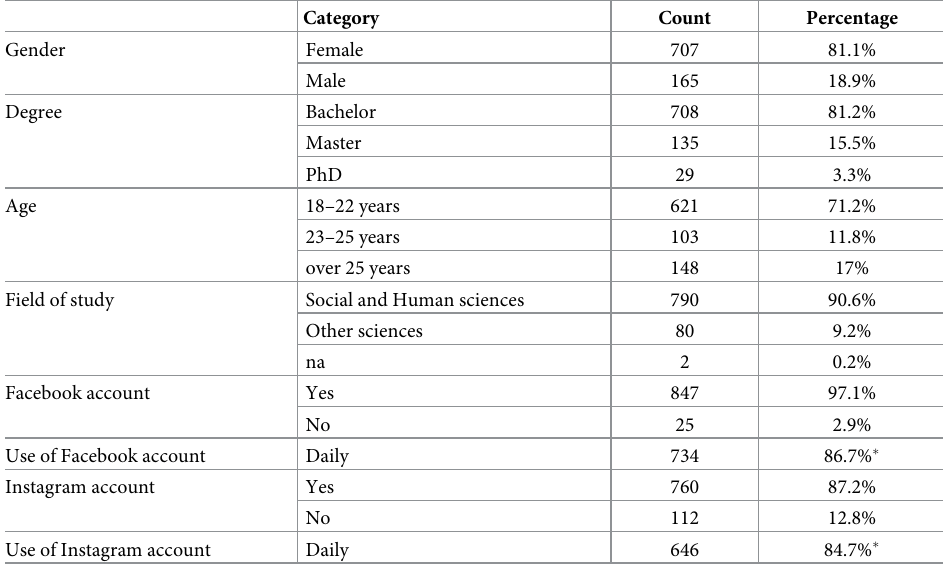
Table 1. Description of sample characteristics (n =